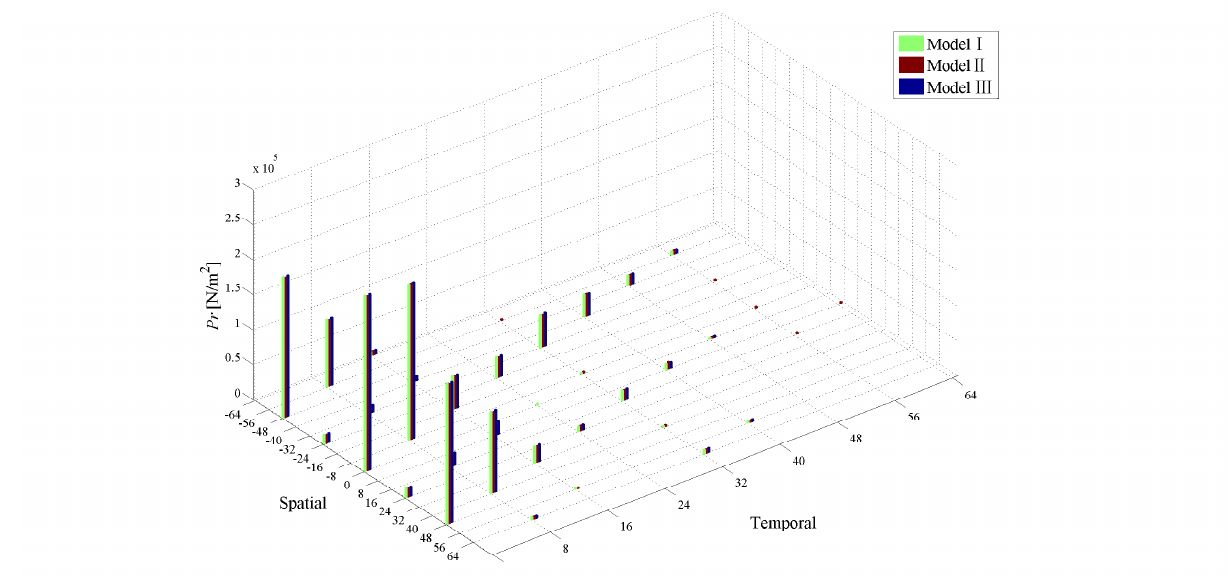
Figure 13. Comparison of 2D FFT results of radial force in three models.